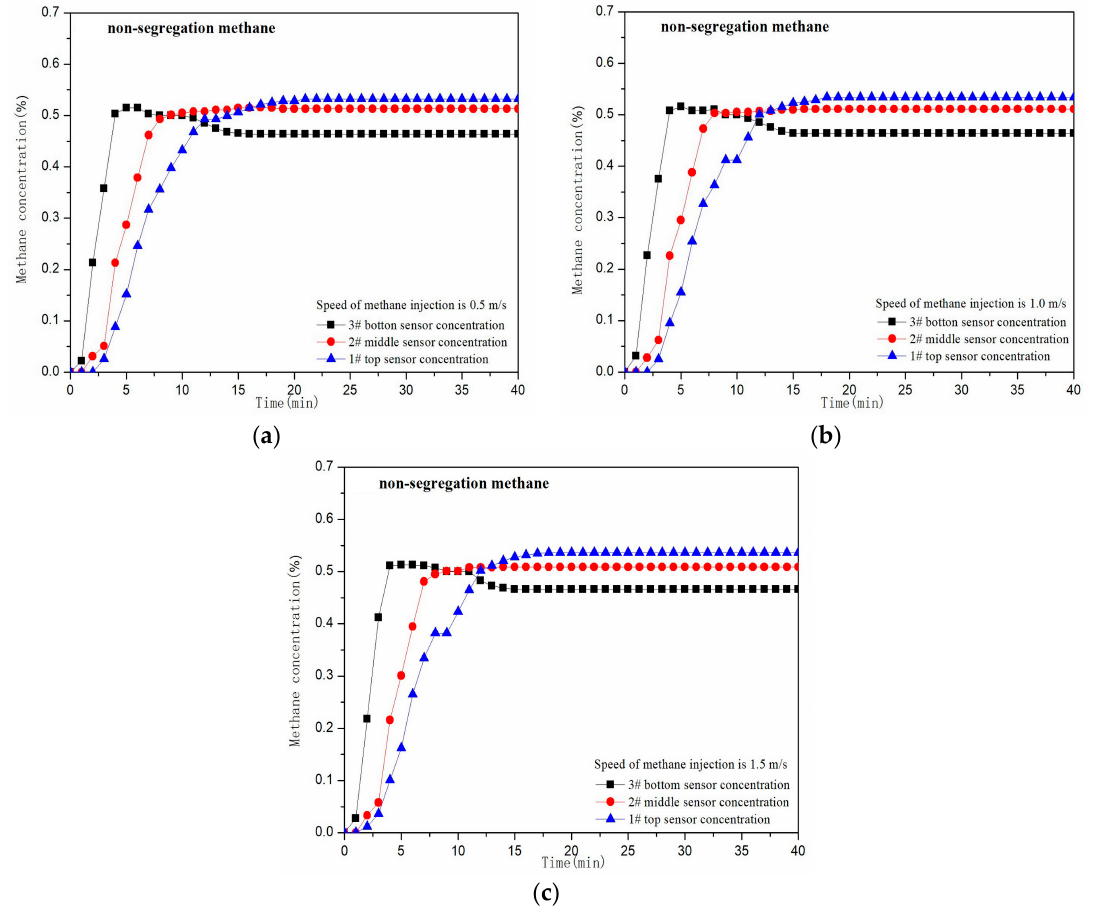
Figure 4. Relation graph of non-segregation methane concentration and time in enrichment tower. ( a ) Speed of methane injection is 0.5 m/s; ( b ) Speed of methane injection is 1.0 m/s; ( c ) Speed of